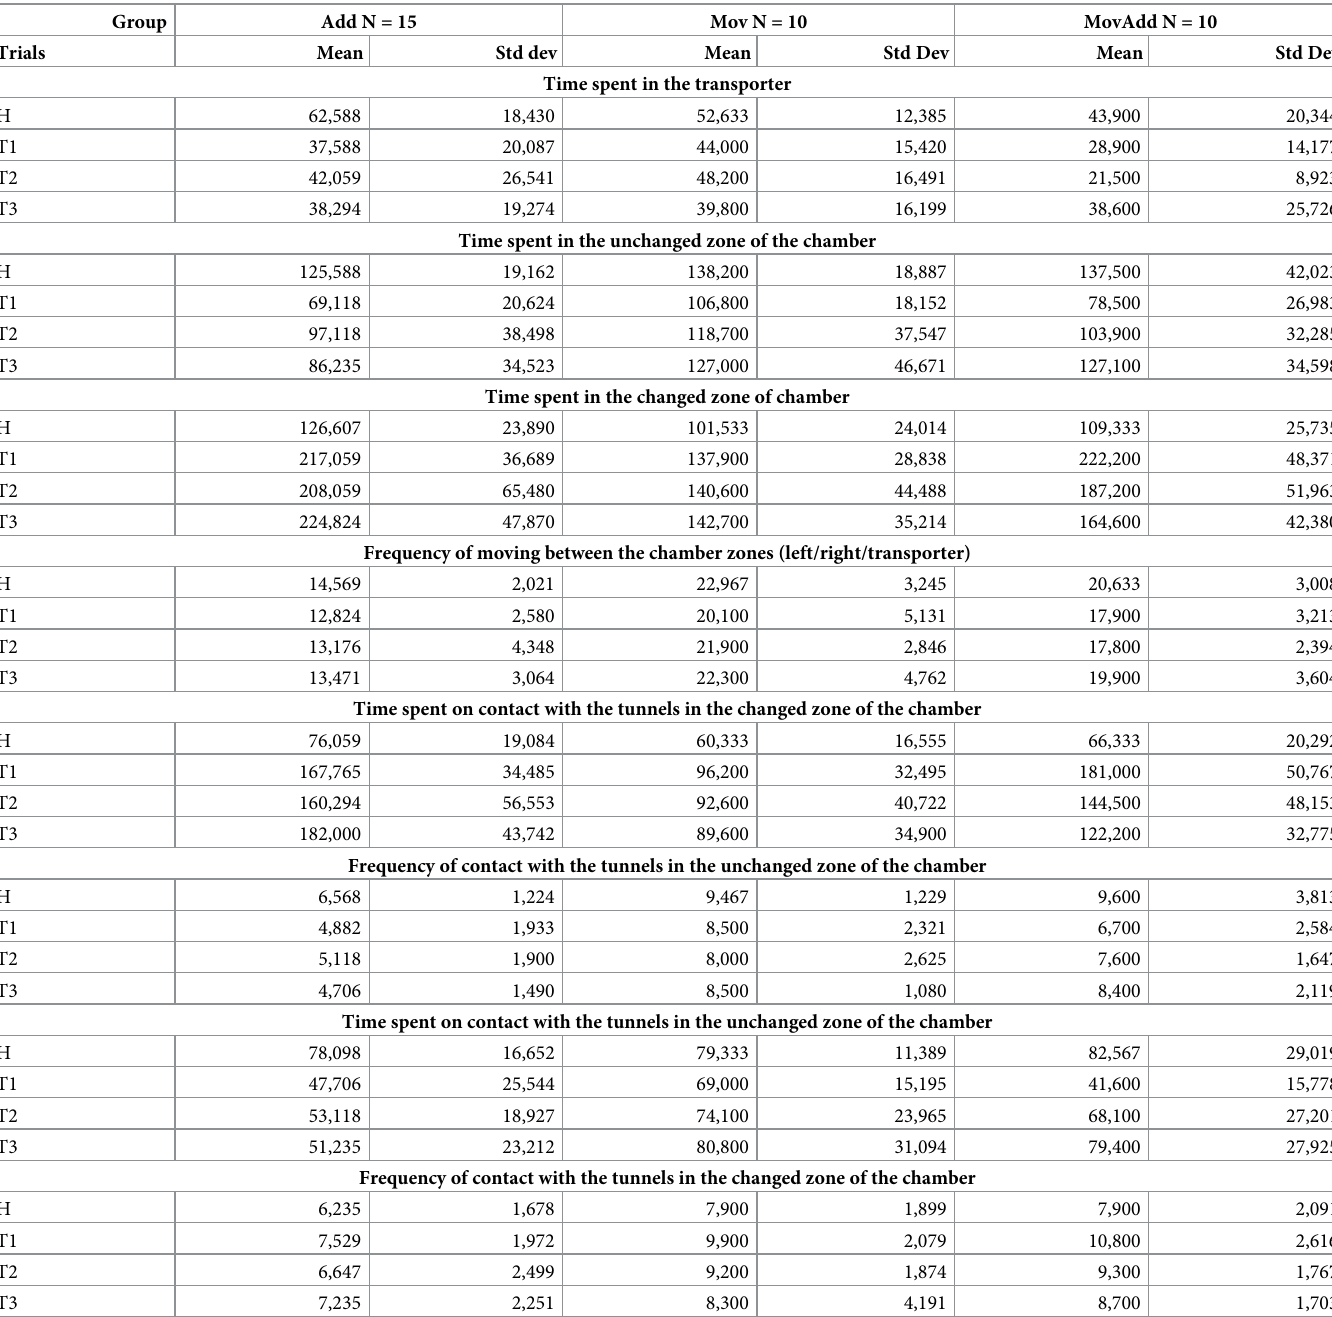
Table 1. Descriptive statistics of all behavioral measurements analyzed in this study. Group Add—addition of novel tunnels; group MovAdd—addition of movable tunnel; group Move—replacement of familiar tunnel for movable one. H—habituation phase; T1-T2—consecutive trials.